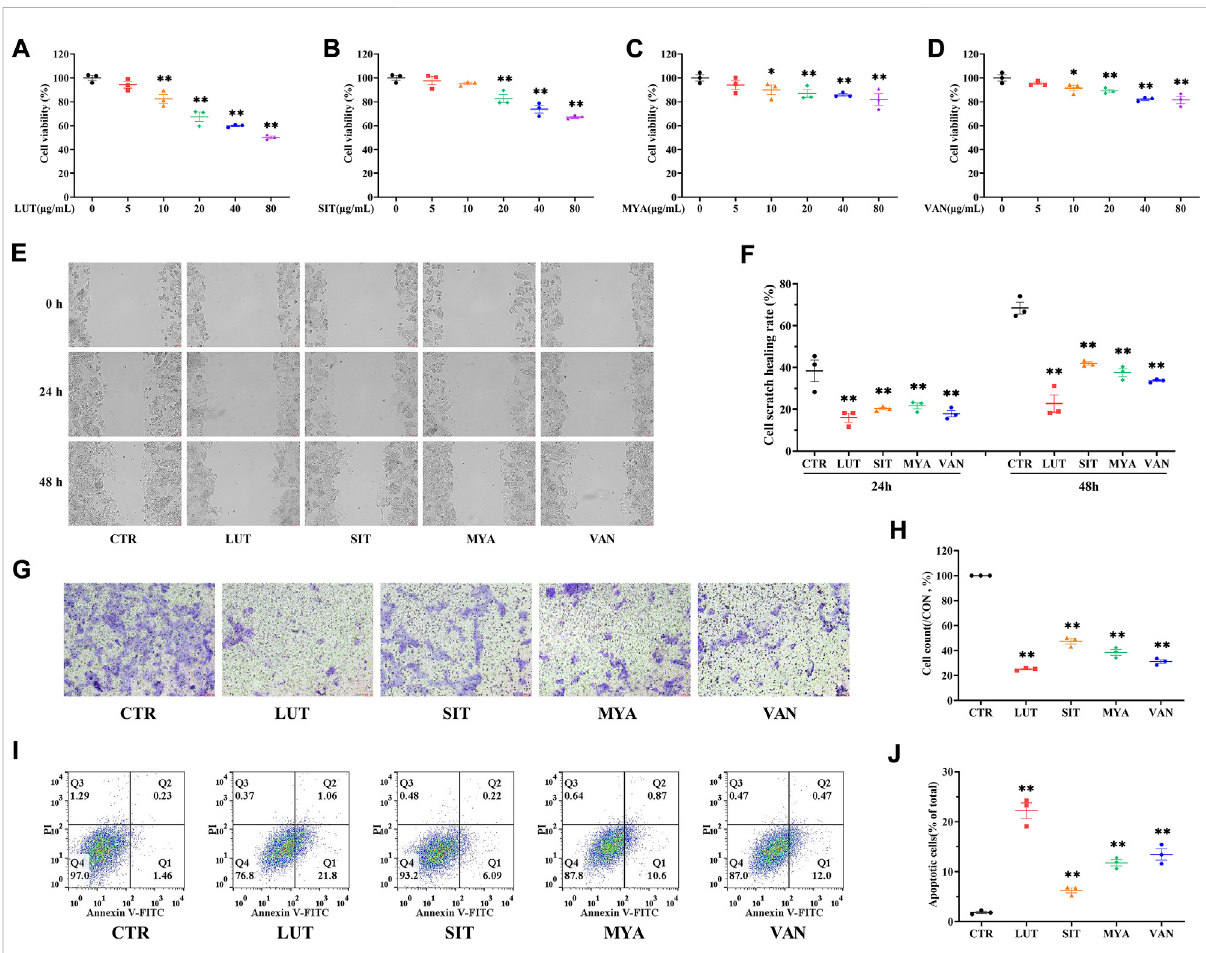
FIGURE 9 YFBP active ingredients inhibit proliferation, migration, and invasion of colorectal cancer cells and promote apoptosis. (A – D) Viability assay of LUT, SIT, MYA, or VAN. (E ,F) Cell scratch assay of LUT, SIT, MYA, or VAN. (G ,H) Cell invasion assay of LUT, SIT, MYA, or VAN. (I,J) Cell apoptosis assay of LUT, SIT, MYA, or VAN. Quantitative results are shown as the mean ± SEM from three independent experiments. * p < 0.05, ** p < 0.01 vs. the CTR